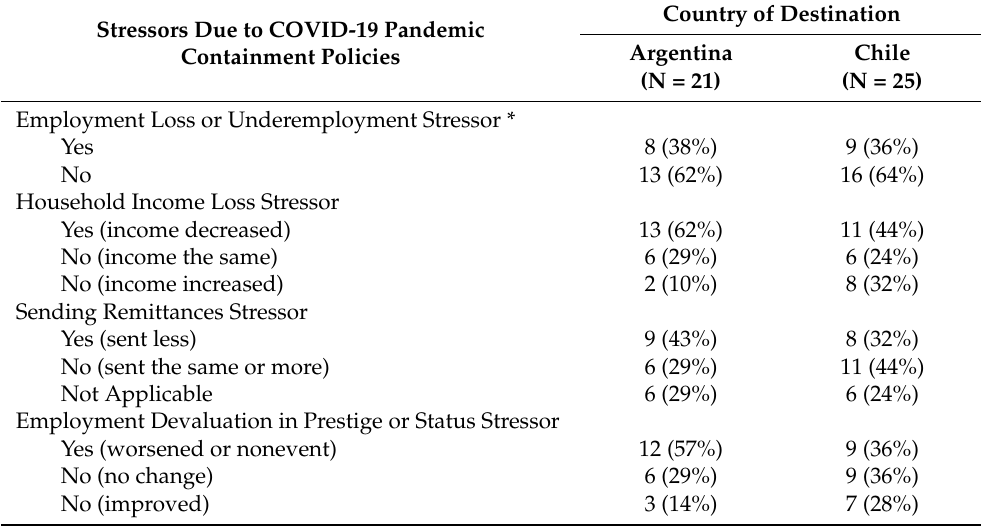
Table 2. The stressors of the COVID-19 governmental containment policies for Venezuelan migrants in Argentina and Chile, Frequency (%). Stressors Due to COVID-19